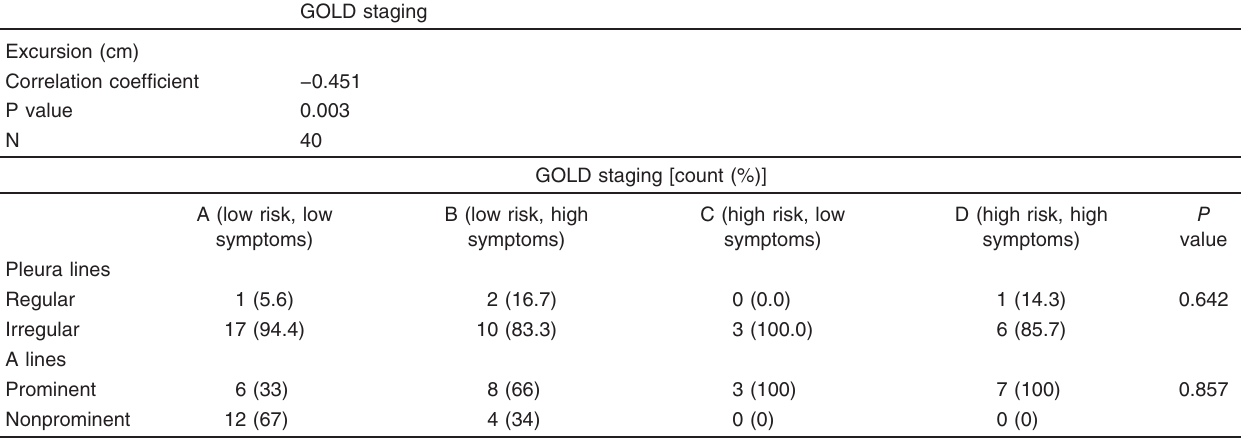
Table 5 Correlation between Global Initiative for Chronic Obstructive Lung Disease staging and pleura lines, A lines, and diaphragmatic excursion GOLD